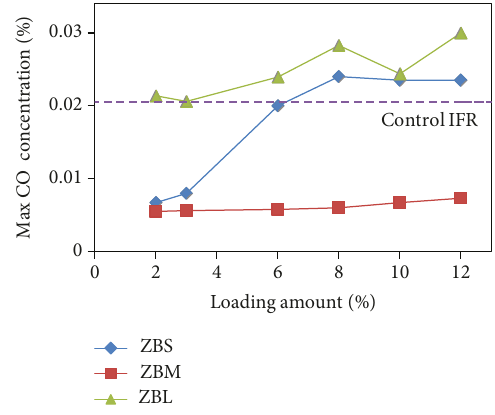
Figure 12: CO concentration wood treated with IFR/ZB coatings.